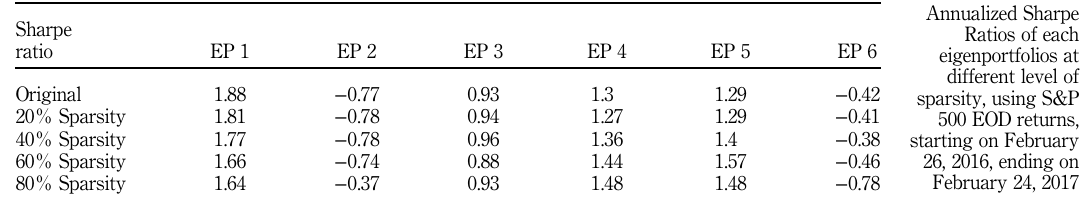
Figure 4. PNL curves of the original and sparsed eigenportfolios for EOD returns of stocks in S&P500